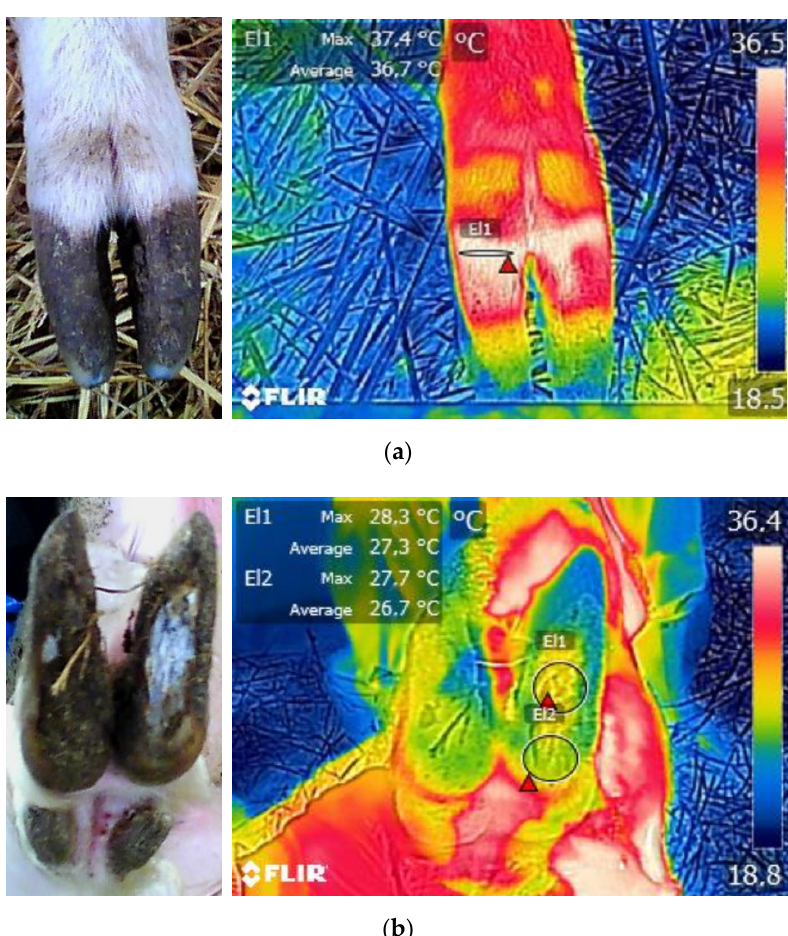
Figure 1. Temperature measurements at: ( a ) the coronary band (T1 = El1), ( b ) the hoof sole (T2 = El1), and the hoof heel (T3 = El2).